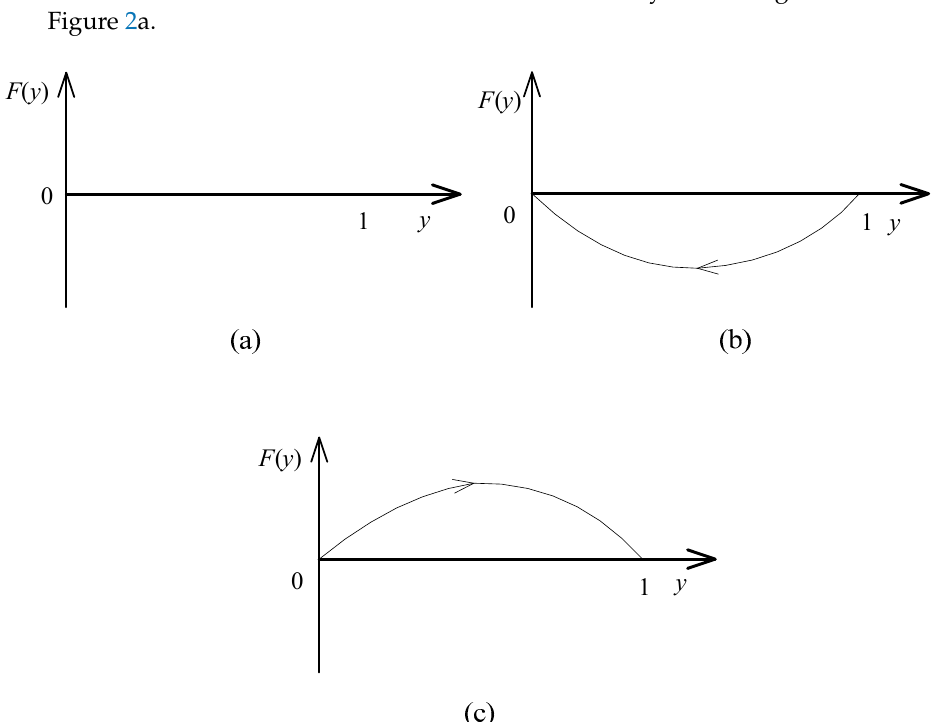
Figure 2. The dynamic evolutionary diagram of export enterprises under various cases. ( a ) The dynamic diagram of company strategy when x = x ∗ . ( b ) The dynamic diagram of company strategy when y = 0 is an evolutionary stable state. ( c ) The dynamic diagram of governmental strategy when y = 1 is an evolutionary stable state.